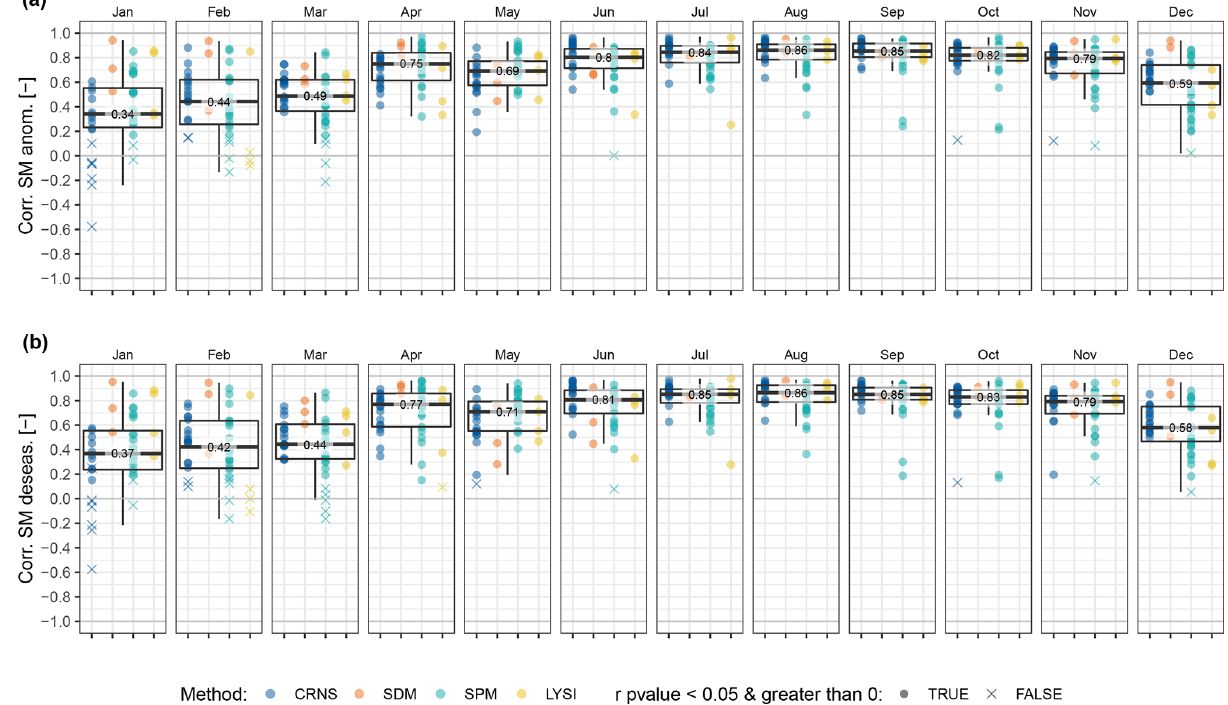
Figure 5. Comparison of the simulated mHM SM (0–25cm) in the GDM-v2-2021 setup to observed SM anomalies without (a) and with (b) subtraction of the mean seasonal SM cycle for each month, depicted with boxplots. SM anomalies are plotted for each location and colored according to the SM measurement method used. Note that sample sizes between measurement methods differ (CRNS: n = 17, SDM: n = 3, SPM: n = 23, LYSI: n = 4). Data points that are not both significantly ( p -value < 0.05) and positively correlated are marked with x. See Fig. A2 for detailed